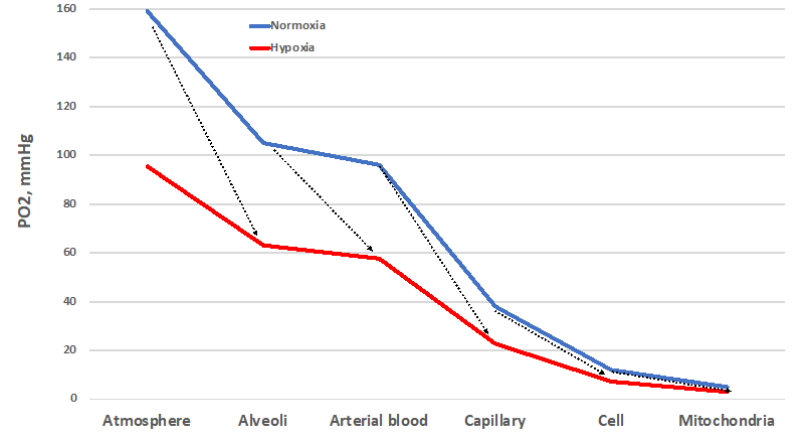
Figure 3. The oxygen cascade in normoxia (blue) and in hypoxia (red, which depicts the situation at 3400 m/13.9 %O 2 ). The arrows indicate the sites of resistance to the O 2 flux that increase the PO 2 gradient. These sites of resistance may convert a normoxic situation into a hypoxic one. Other explanations in the text.